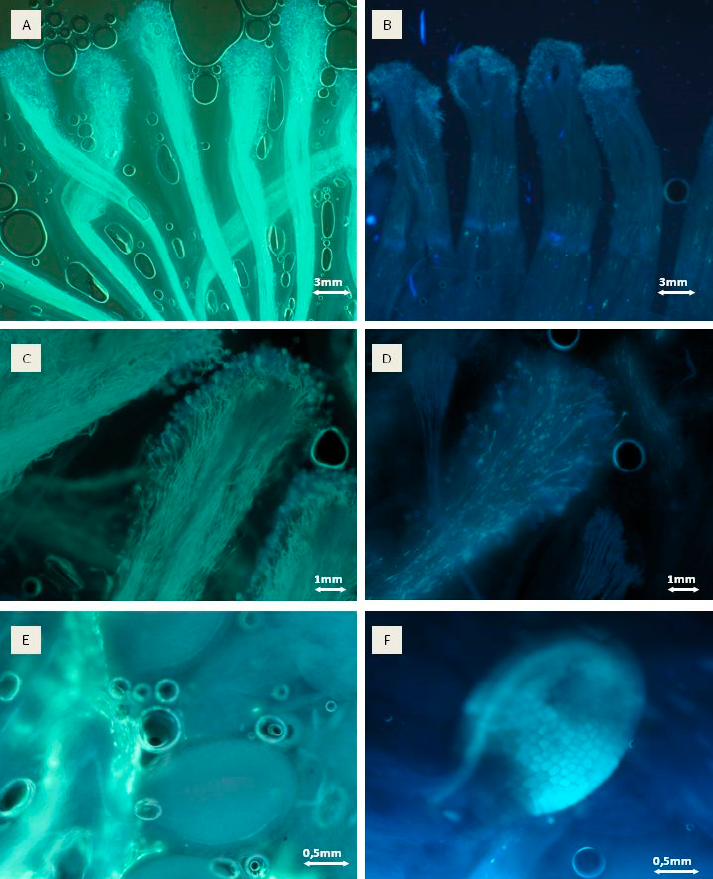
Figure 3. Pollen tube growth. ( A , C , E )—pollen tube growth rated 3 according to Table 1; ( B , D , F )— pollen tube growth rated 1 according to Table 1. ( A , B )—growing through the style; ( C , D )—pollen grains germinating on stigma; E —pollen tubes near ovules; F —non fertilized.